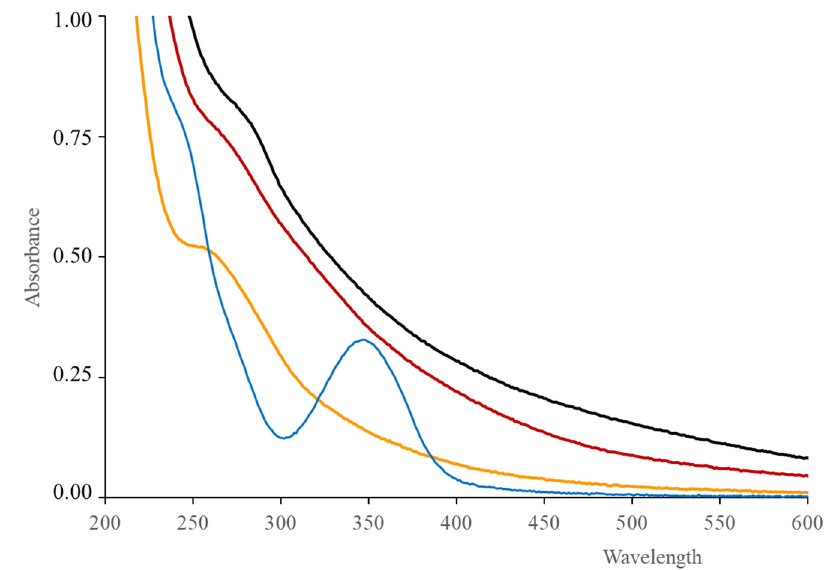
Figure 3. Optical absorption spectra of GCDs ( — ), TCDs ( — ), P1CDs ( — ) and P2CDs ( — ) in aqueous solution.